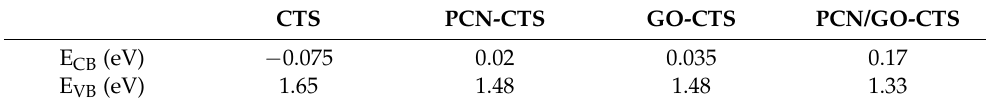
Table 2. Energy band state values of CTS, PCN-CTS, GO-CTS, and PCN-CTS.